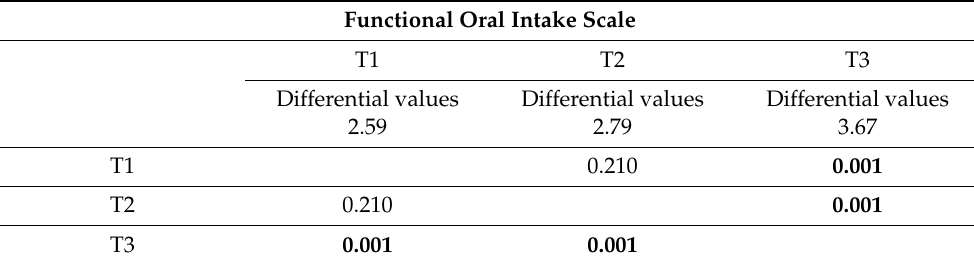
Table 2. Results of posthoc tests for the Functional Oral Intake Scale prior to rehabilitation, after clini- cal assessment, and after FEES diagnostics.